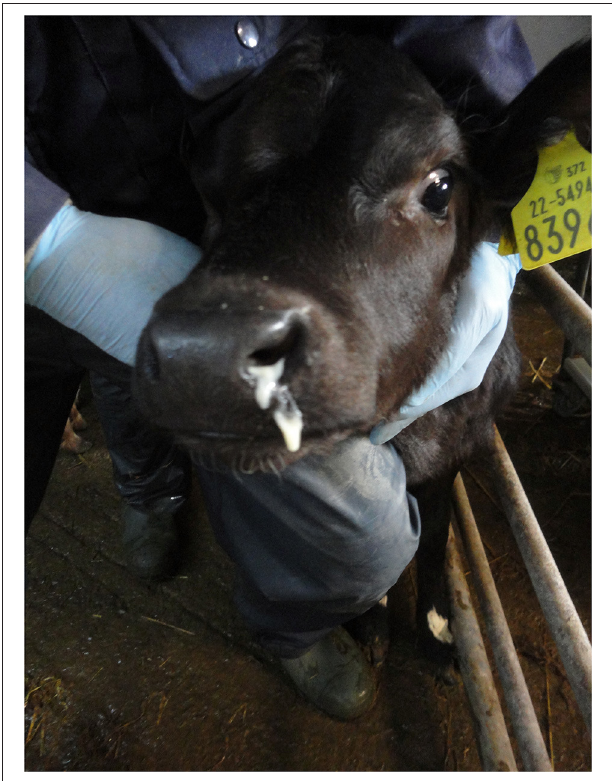
FIGURE 5 | Nasal discharge in a calf with respiratory tract infection.